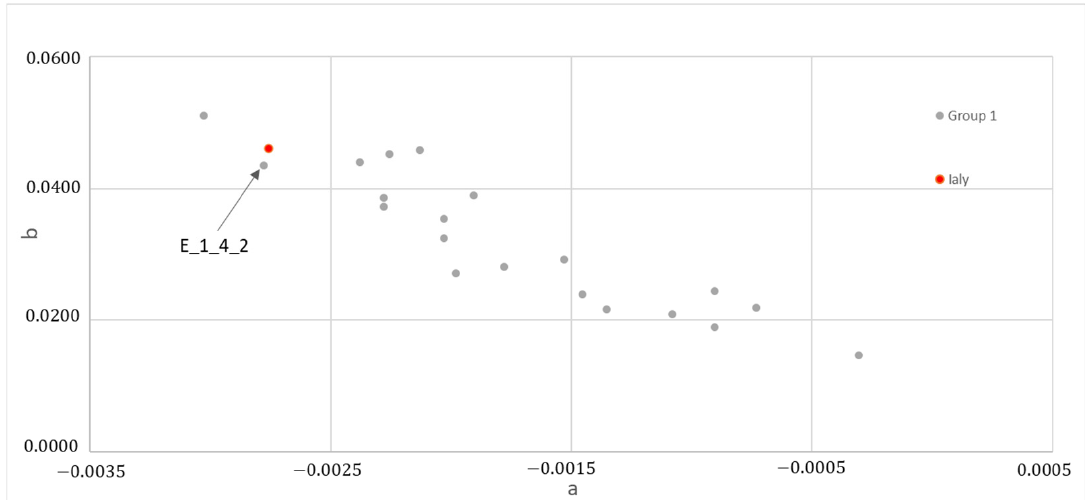
Figure 8. The coefficients plot of group 1 and Ialy hydropower plant.